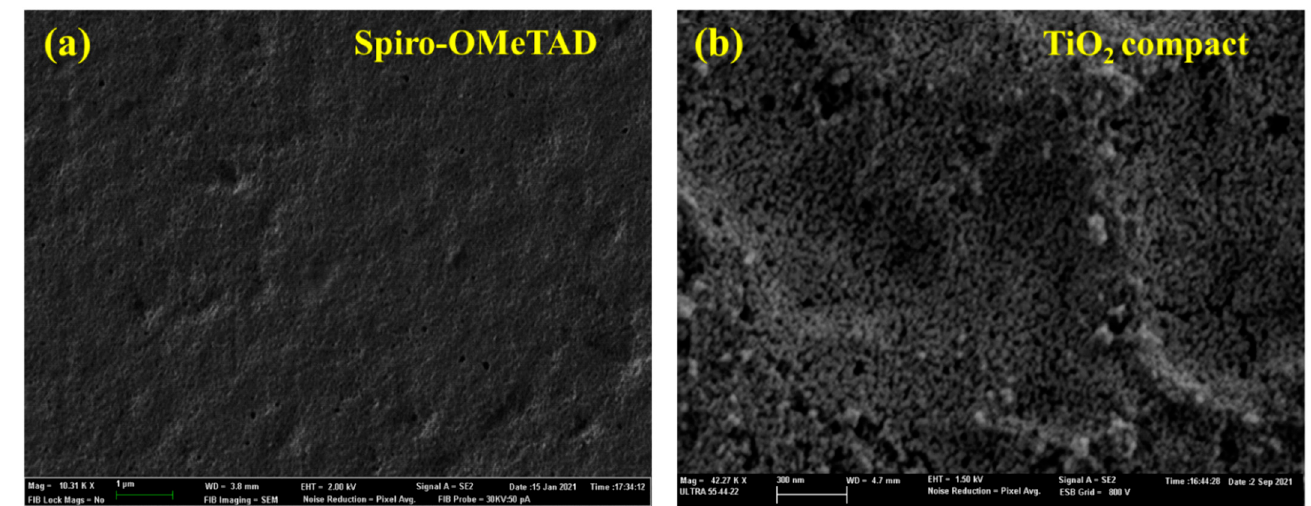
Figure 9. ( a ) SEM image of the Spiro-OMeTAD film, ( b ) SEM image of the TiO 2 compact layer. Table 5. Average performance of the Spiro-OMeTAD/MASnI 3 /C-TiO 2 /FTO devices. Device.